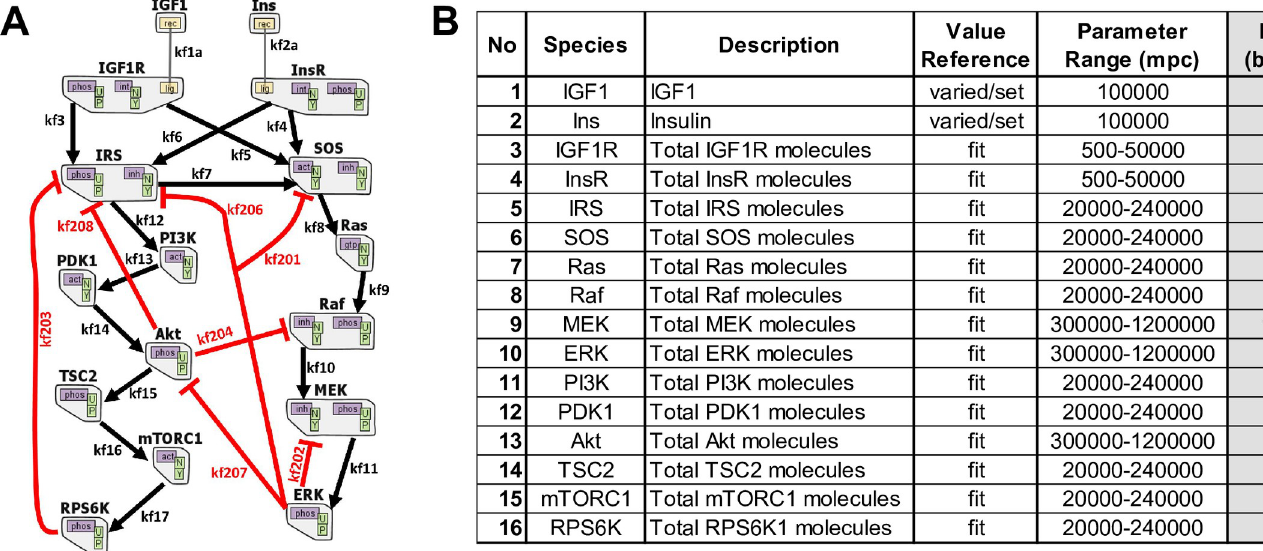
Fig 1. The computational mechanistic model representation. (A) The topology of the dual IGF1R/InsR signaling network is illustrated. The model includes 16 proteins. Black arrows represent activation, and red lines indicate inhibition of the corresponding active molecule. The graph is adapted from RuleBender software. (B) The initial molecule numbers of the species in the model. The ranges of parameter values and the “best-fit” values are reported. mpc: molecules per cell.